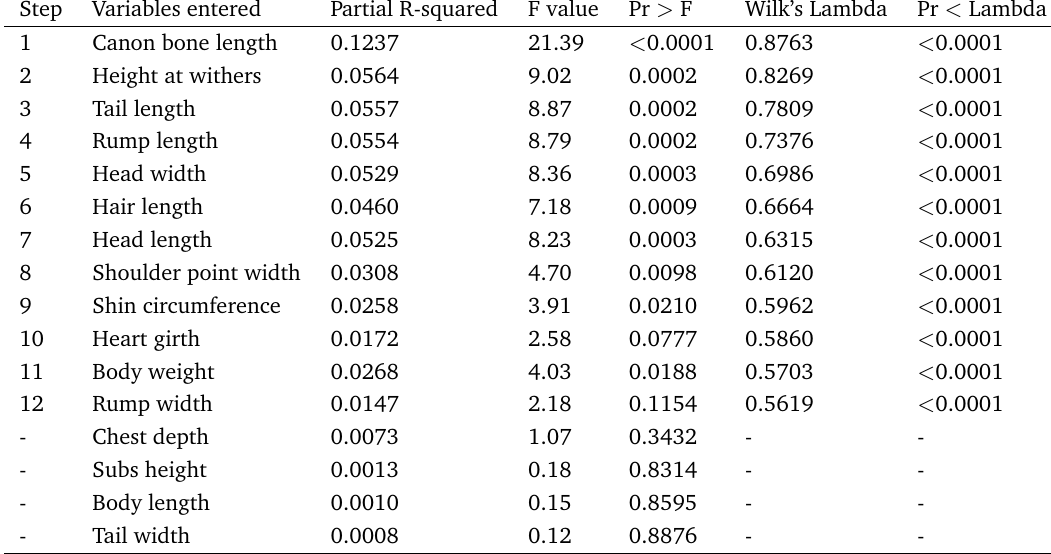
Table 6. Summary of the stepwise discriminant function analysis; ascending order of traits used in discriminating the sheep populations from different agro-ecological zones.